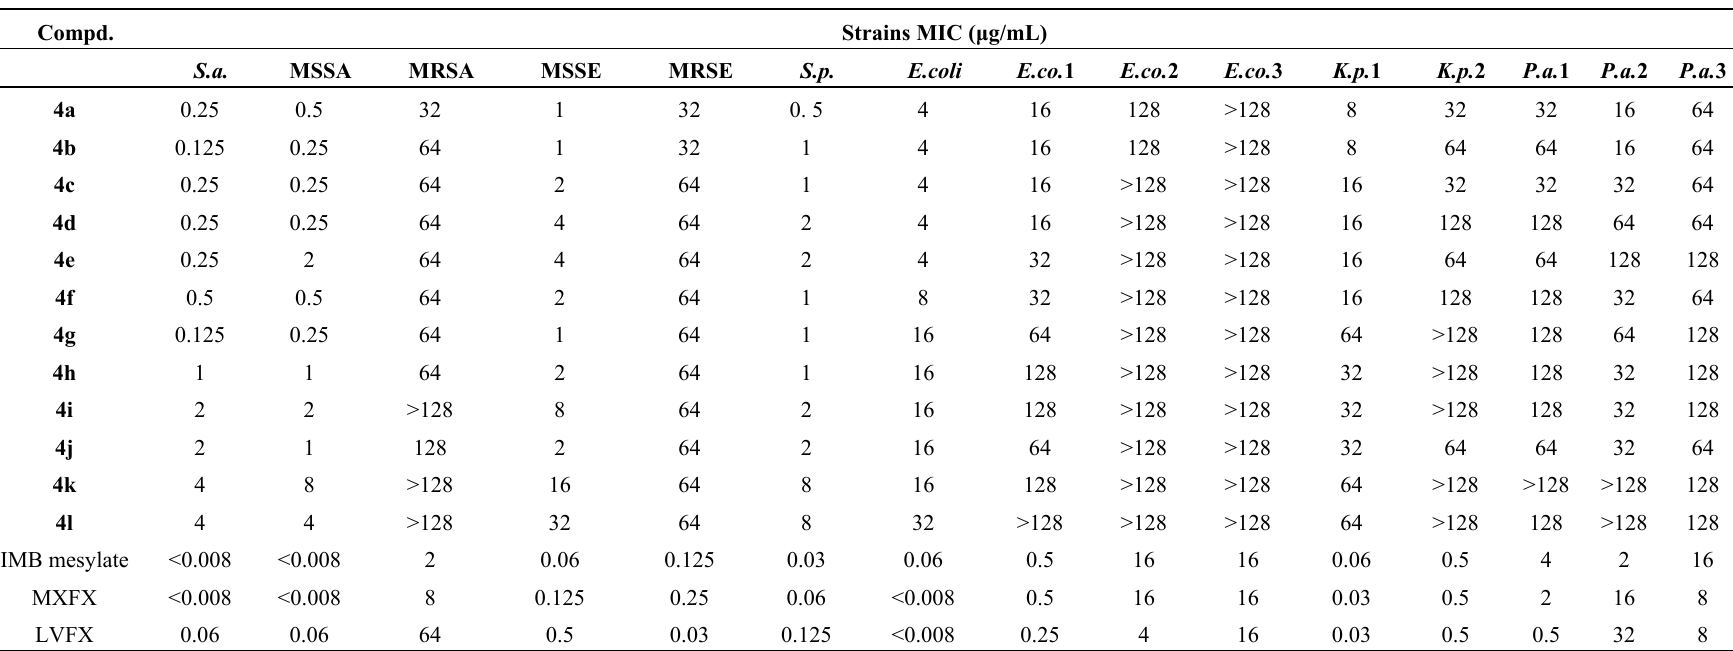
Table 2. In vitro activity of compounds 4a – l against Gram-positive and Gram-negative